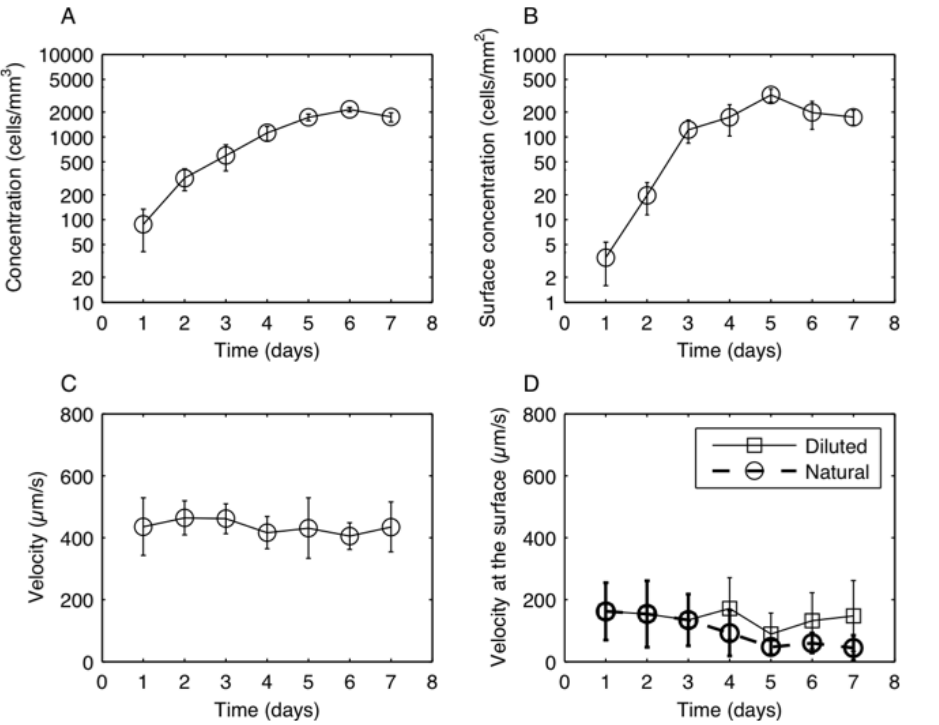
Figure 2. Characterization of cells’ behavior away from interfaces and at the WAI. This was done for six different inocula over a period of 7 days. The error bars indicate the standard deviation. (A) Growth curve of T. thermophila . (B) Change in the surface concentration of T. thermophila . (C) Change in the swimming velocity away from any interfaces. (D) Change in the swimming velocity at the WAI in a diluted or natural suspension.